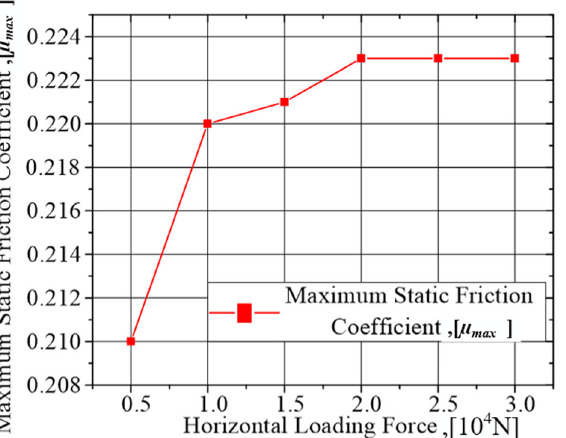
Figure 2. The relationship between the maximum static friction coefficient of micron and the hori- zontal loading force.